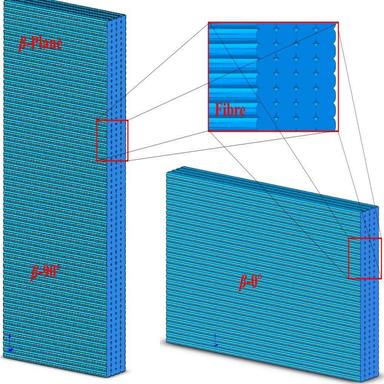
The micro-structure of the plates on β plane.